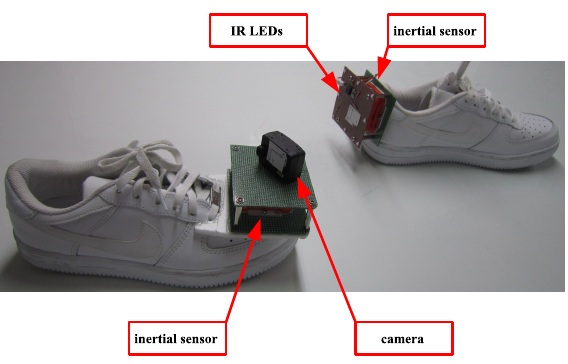
Figure 1. Picture of the proposed system.